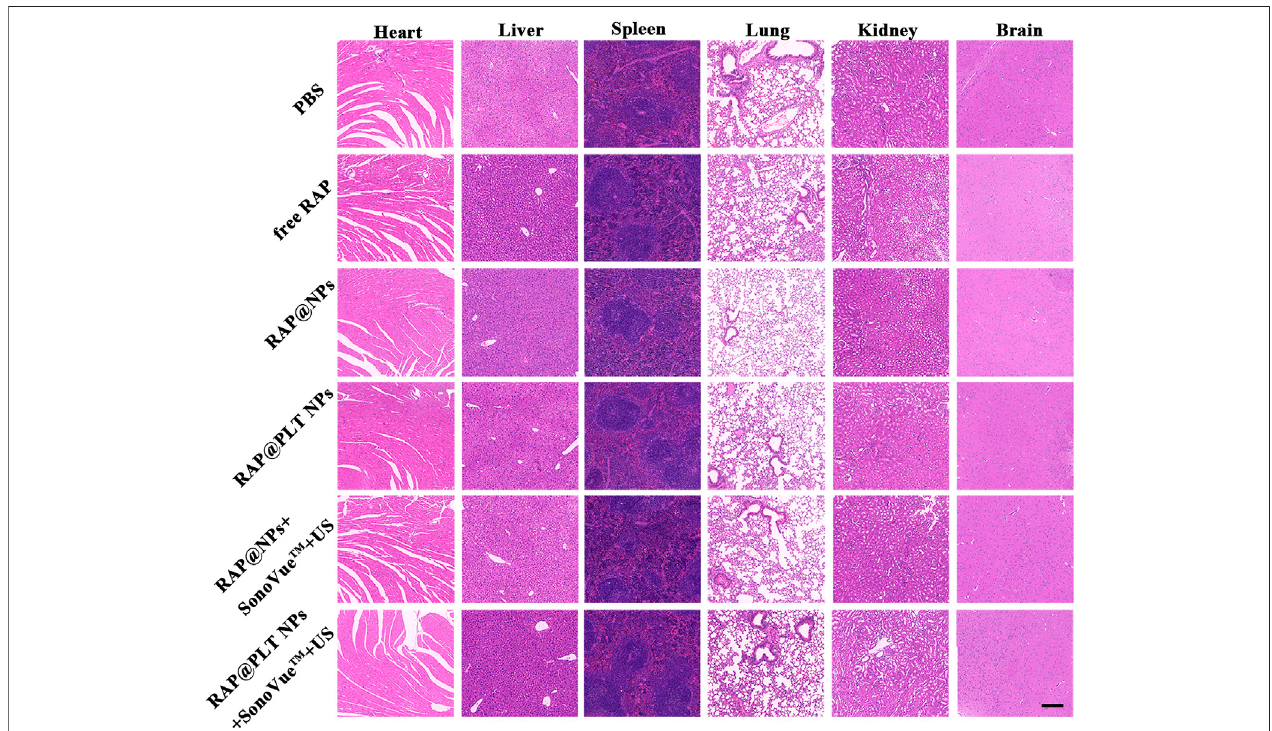
FIGURE11| HistologicalobservationoftheorganscollectedfromtheApoE − /- miceafterthetreatmentatday30.TheorgansectionswerestainedwithH&E.Scale bar: 200